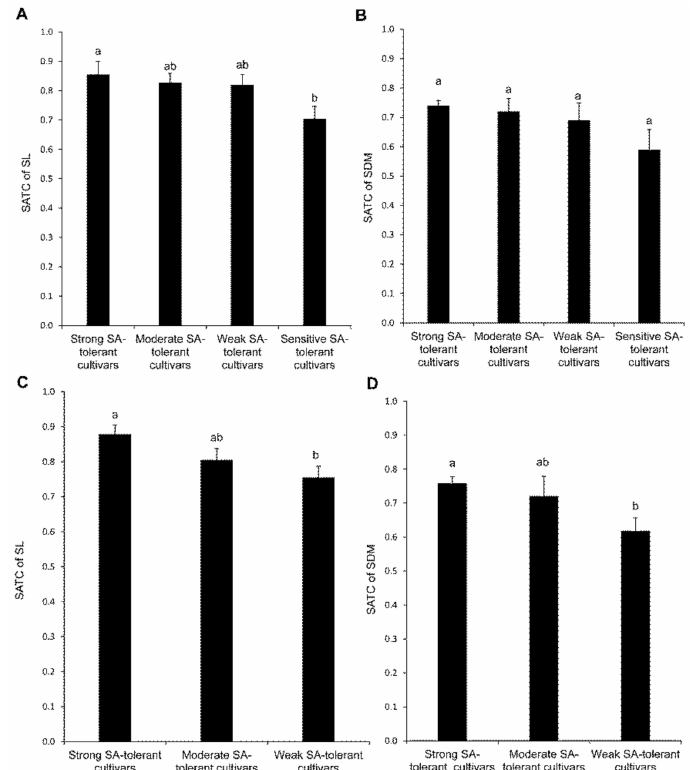
Figure 5. The saline-alkaline-tolerance coe ffi cients (SATCs) of stem length (SL) (A,C) and shoot dry mass (SDM) (B,D) in di ff erent categories based on two methods. (A,B) Traditional method. (C,D) New method. Abbreviations: SL, stem length; SDM, shoot dry